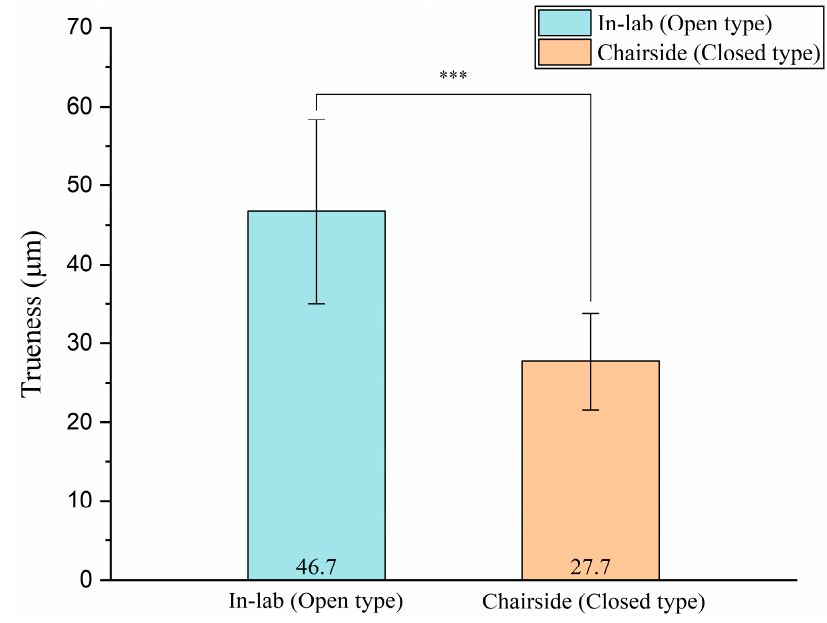
Figure 7. Comparison of the trueness mean values by digital workflows. ***, Significant ( p < 0.001).